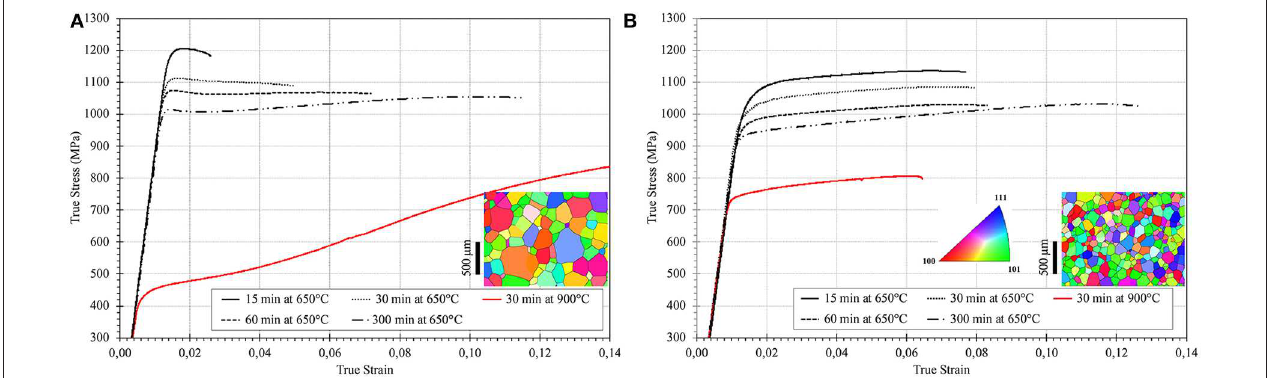
TABLE 1 | Room temperature mechanical properties of Ti35-5-5 obtained from stress–strain engineering curves performed at a strain rate of 10 − 4 s − 1 for different annealing times at 650 ◦ C and for 30min at 950 ◦ C. Ti35-5-5 Young modulus Yield strength Ultimate Elongation D α D β E (GPa) R p 0.2 (MPa) tensile strength (MPa) 15min at 650 ◦ C 85 1,178 1,185 0.014 290 ± 78nm 318 ± 85 nm 1,090 1,095 322 ± 102nm 363 ± 93 nm 87 1,056 1,060 368 ± 92nm 441 ± 108 nm 300min at 650 ◦ C 86 998 1,002 0.157 504 ± 128nm 590 ± 180 nm 30min at 900 ◦ C 79 430 760 0.260 — 170 ± 100 µ m Grain size evolution D α and D β are also shown.